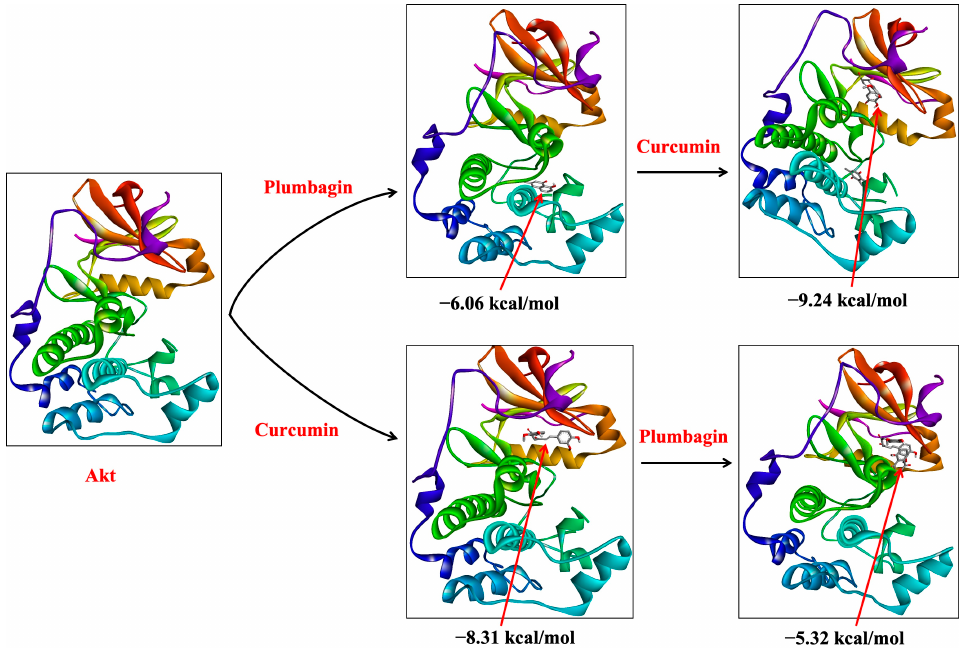
Figure 3. Sequential binding of curcumin and plumbagin after docking against Akt protein. The red arrows indicate the position of bound ligand on the target protein.